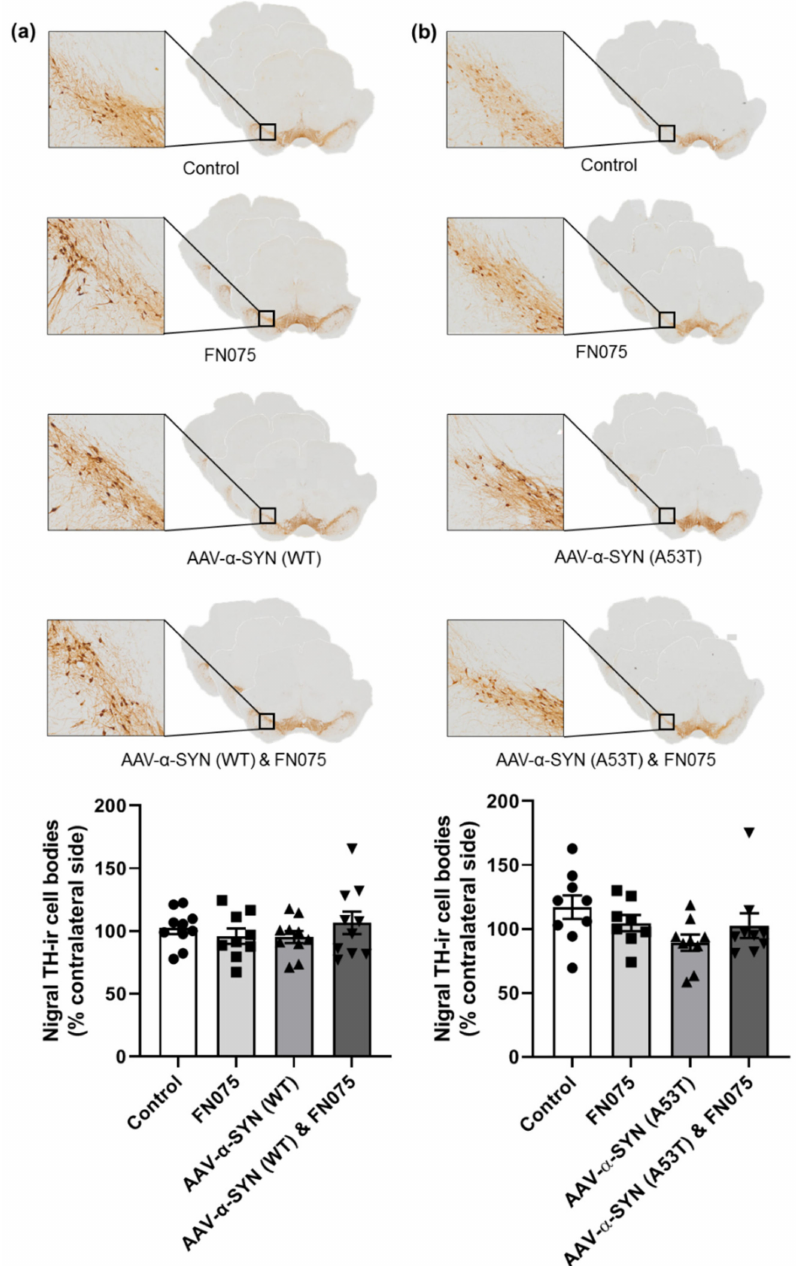
Figure 6. Immunohistological assessment of the impact of AAV- α -synuclein vectors alone or in combination with FN075 on nigral cell counts. ( a ) AAV- α -SYN (WT) or ( b ) AAV- α -SYN (A53T), either alone or in combination with FN075, did not significantly affect the number of TH-immunoreactive cell bodies in the substantia nigra. Data are represented as mean ± SEM with n = 8–10 animals per group by one-way